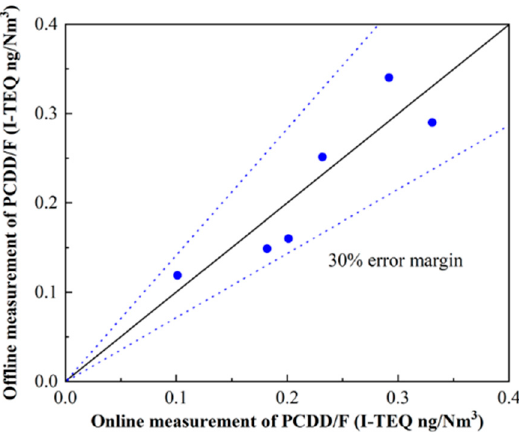
Figure 2. Comparison between online measurement and offline measurement of PCDD/F.